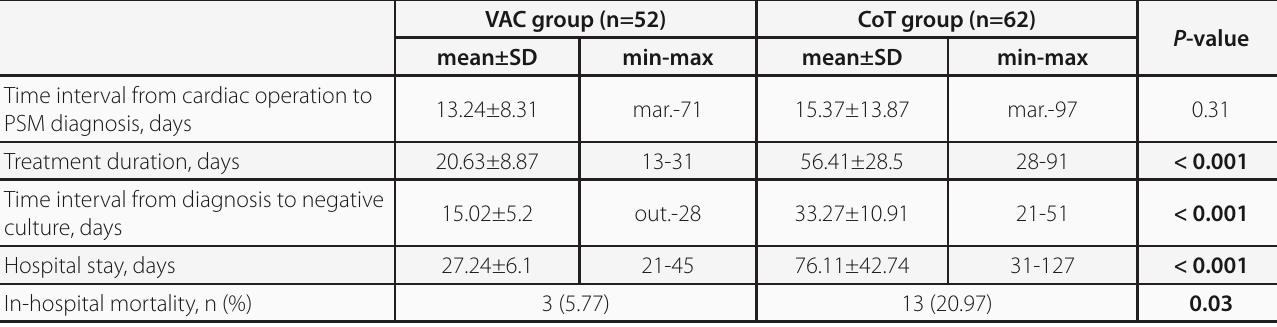
Table 6. Post-sternotomy mediastinitis (PSM) associated characteristics of the study population.